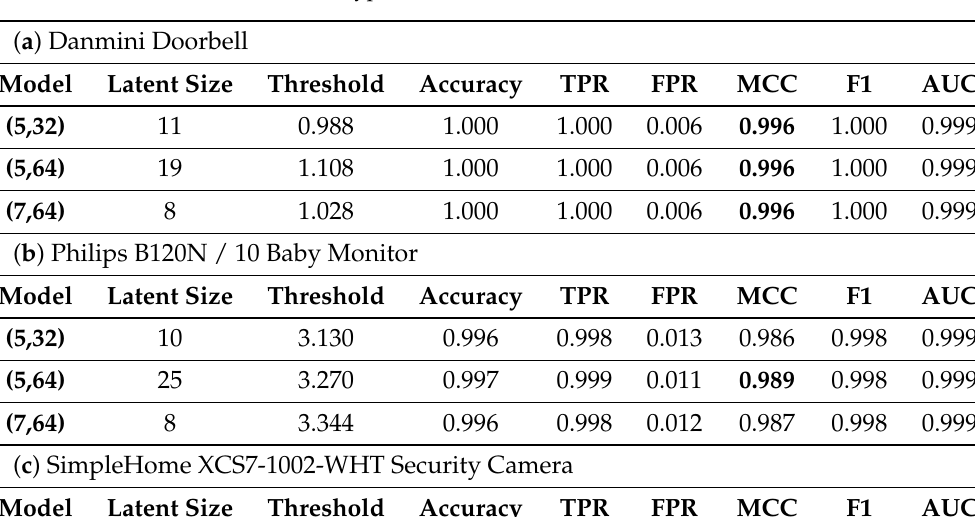
Table 11. Evaluation results per device type with N-BaIoT Data. The best configuration from each model structure was chosen based on the MCC score. The reported metrics are averaged over 5 runs. The best MCC score of each device type is marked in bold.